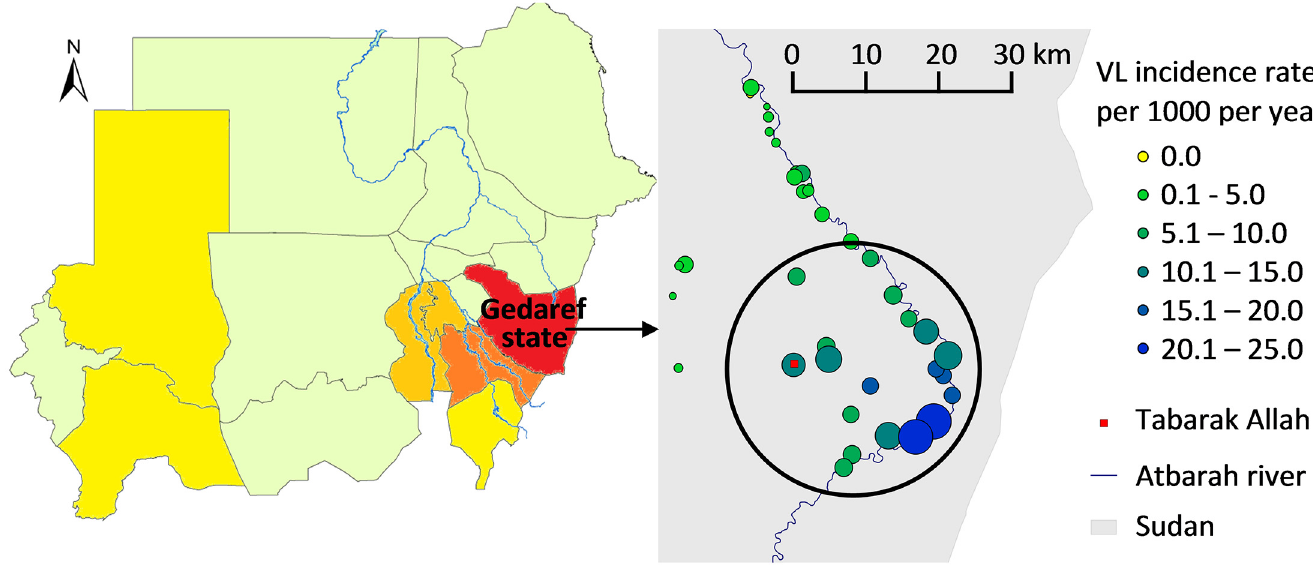
Fig 1. Study area, case-control study on determinants of visceral leishmaniasis, Gedaref State, Sudan, 2012 – 2013. Left map: Annual incidence of visceral leishmaniasis (VL) in Sudan (2011) from < 5 cases /100,000 inhabitants (yellow) to (cid:1) 15 cases /100,000 inhabitants (red) (Source: Annual Report, Federal Ministry of Health, Sudan). Right map: Annual incidence of VL in Sudan (2011) proportionate to the size and colour of the circles (from 0 to (cid:1) 20 cases /1,000 inhabitants). The black circle includes the 24 study